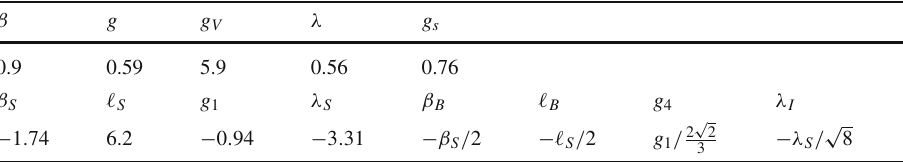
Table 1 The parameters and coupling constants adopted in our calculation. The λ and λ S , I are in the unit of GeV − 1 . Others are in the unit of 1